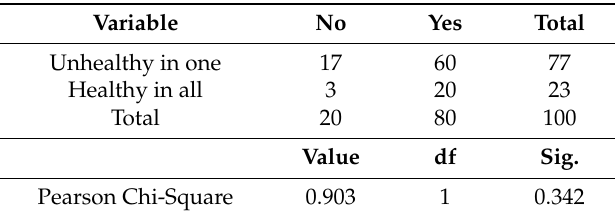
Table 4. Crosstab